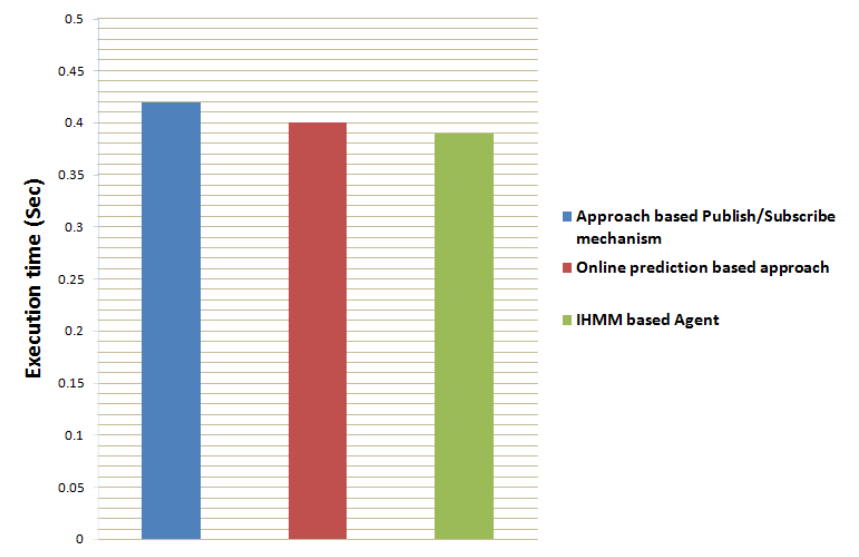
Figure 9. Execution time